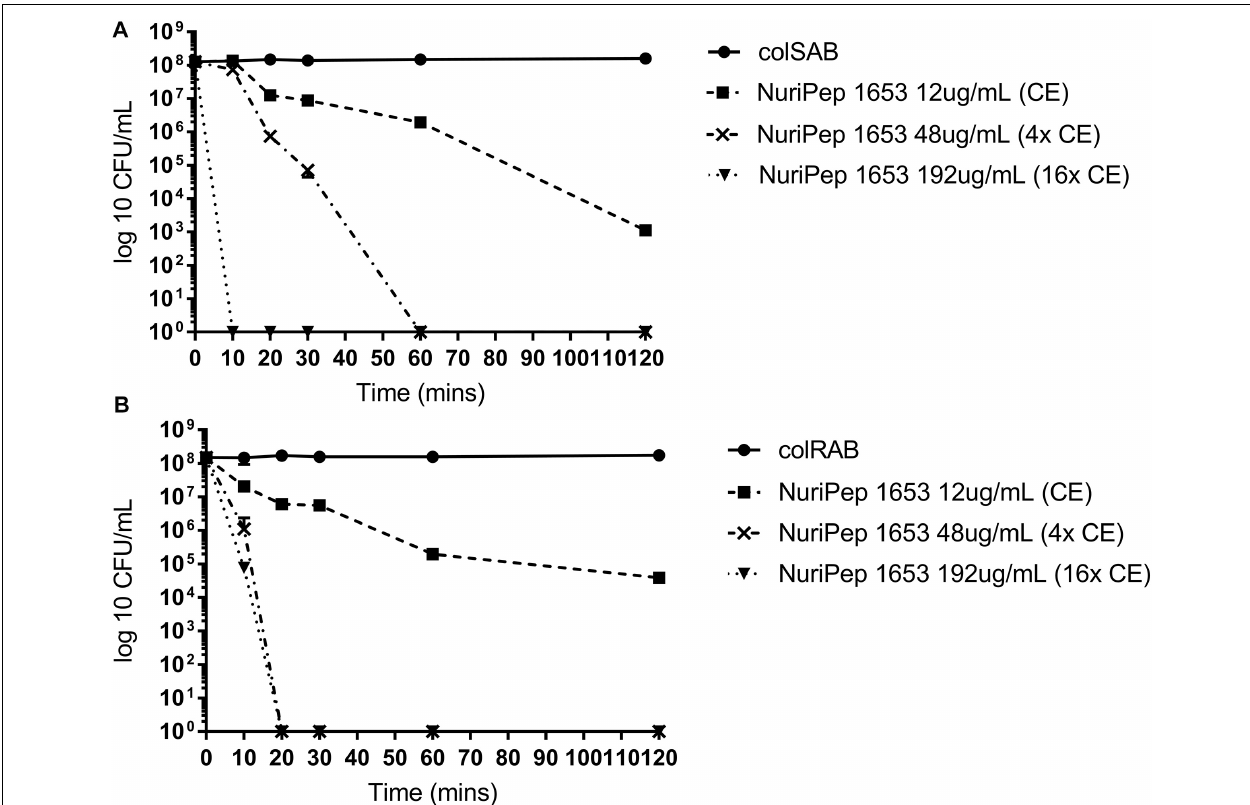
FIGURE 4 | Killing kinetics of NuriPep 1653 against colRAB and colSAB. The killing activity of NuriPep 1653 against (A) colSAB and (B) colRAB was monitored for 120 min. Peptide treatments at 1 × CE (12 µ g/mL), 4 × CE (48 µ g/mL), and 16 × CE (192 µ g/mL) concentrations were tested. The CFU/mL was calculated at the timepoints 10, 20, 30, 60, and 120 min and was compared to the untreated control. Data represent the mean of three experiments performed in triplicate and is expressed as the mean ± standard deviation.